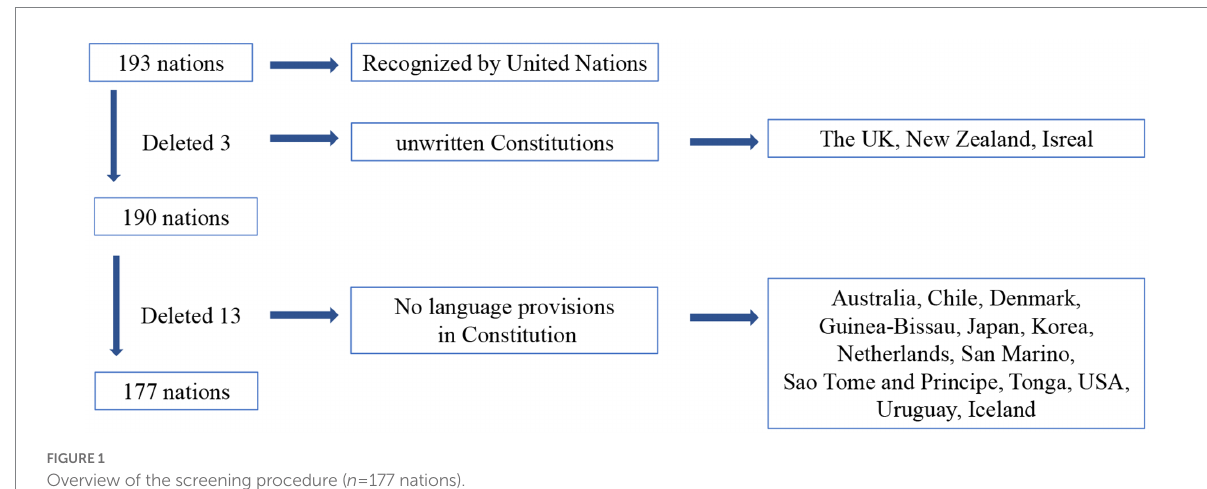
FIGURE 1 Overview of the screening procedure ( n = 177